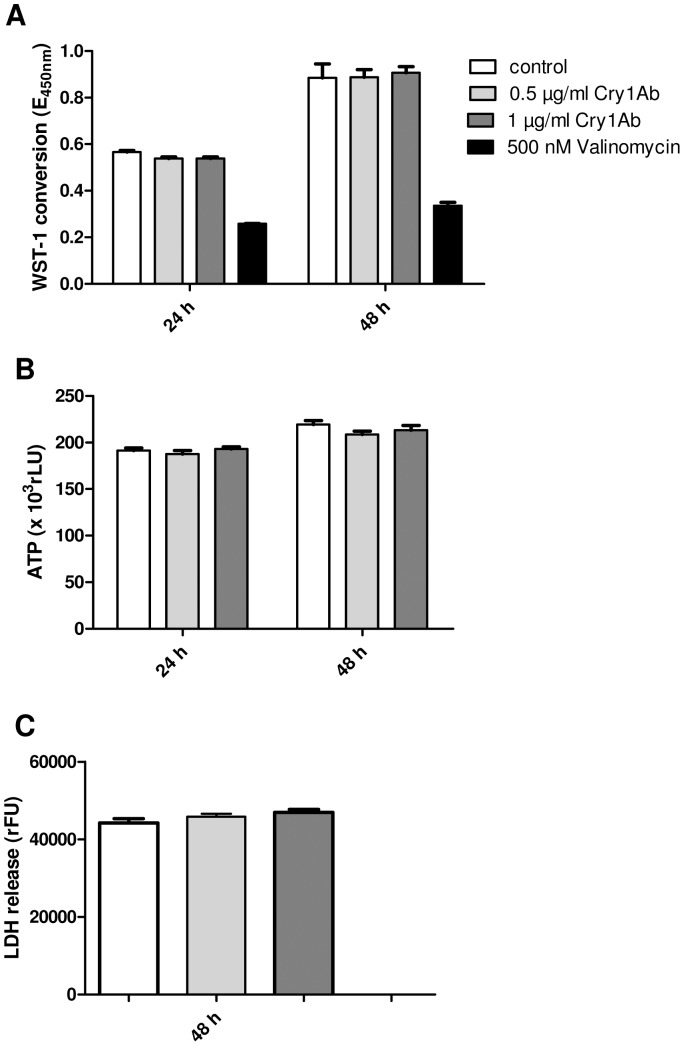
Effect of Cry1Ab on viability of IPEC-J2 cells.IPEC-J2 cells were incubated with indicated concentrations of Cry1Ab for 24 h and 48 h, respectively. Data are from one representative experiment out of 2 performed. (A) The Cell Proliferation Reagent WST-1 (Roche) was used to measure mitochondrial dehydrogenase activity of viable cells. Valinomycin was used as cell damaging control. Bars represent the mean +/−S.D. of 5 replicate wells. (B) The CellTiter-Glo Luminescent Cell Viability Assay (Promega) was used to estimate the number of viable metabolically active cells based on quantitation of ATP. Bars represent the mean +/−S.D. of 5 replicate wells. (C) The CytoTox-ONE™ Homogenous Membrane Integrity Assay (Promega) was used for estimating the number of dead cells by release of LDH from damaged cells. Bars represent the mean +/−S.D. of 12 replicate wells.